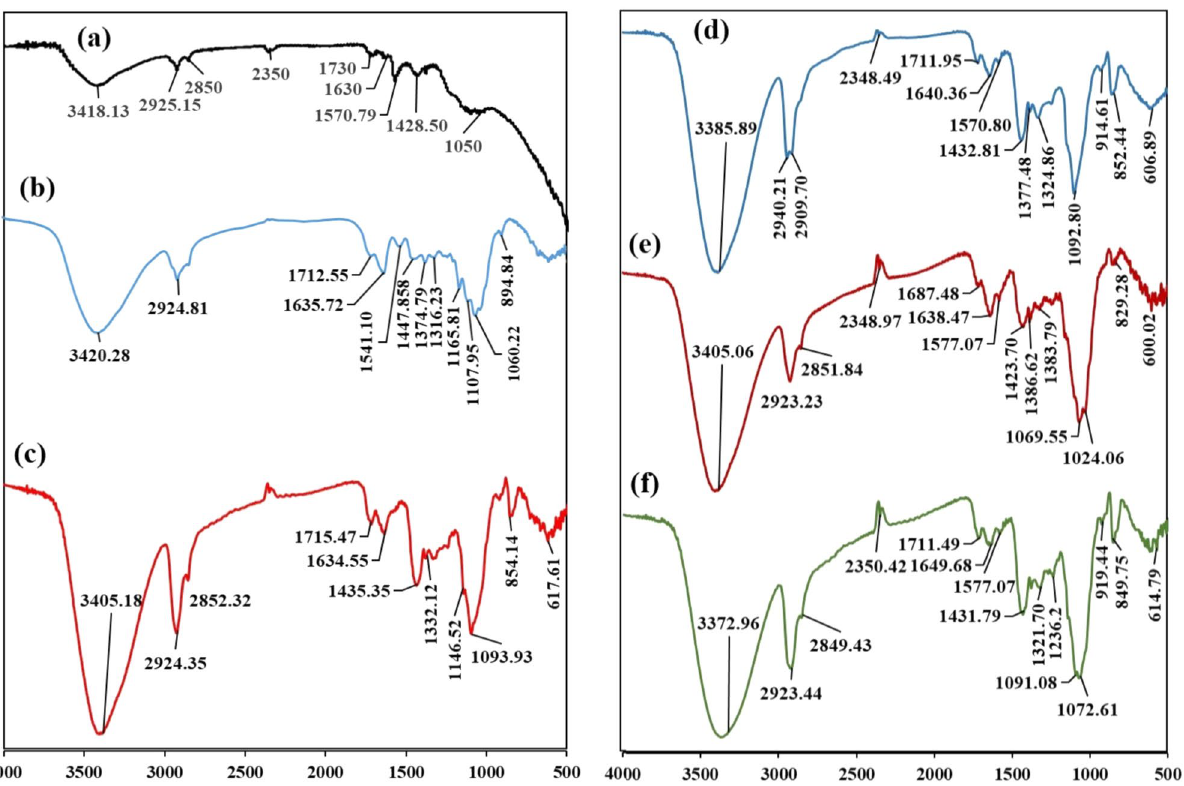
Figure 2. FT-IR spectra of ( a ) Graphene oxide, ( b ) Cellulose nanocrystals, ( c ) Cellulose nanocrystals/graphene oxide film, ( d ) Cellulose nanocrystals/graphene film after Fe(II) adsorption, ( e ) Cellulose nanocrystals/graphene film after Fe(III) adsorption, ( f ) Cellulose nanocrystals/graphene film after binary adsorption of Fe(II) and